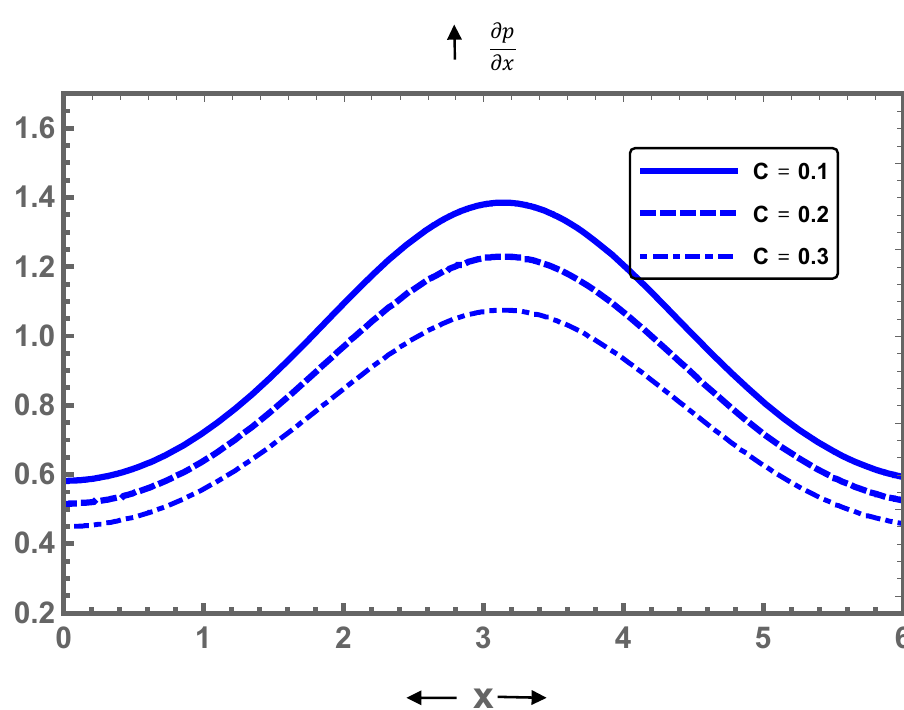
Figure 18. Display of pressure gradient for different values of C .